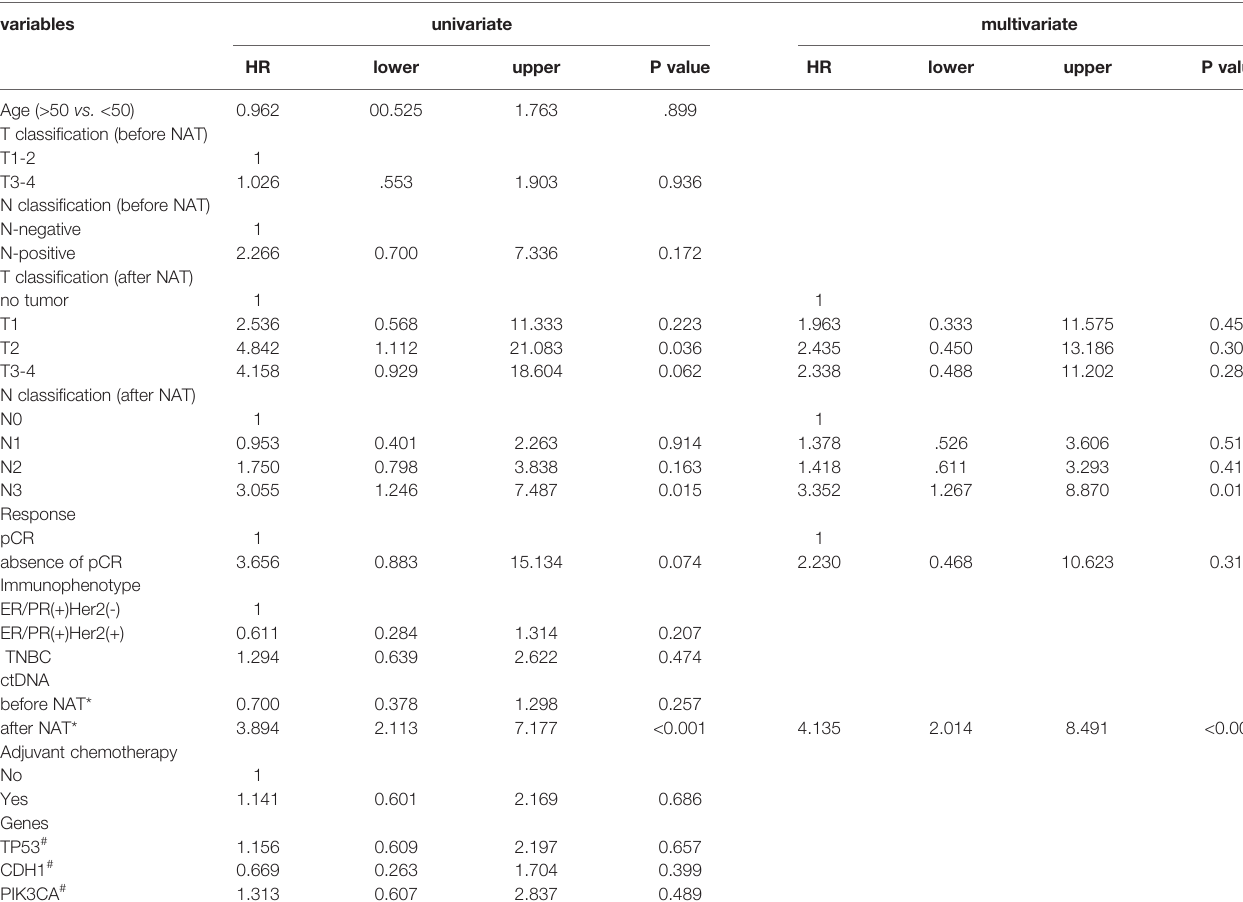
TABLE 2 | Univariate and multivariate analysis of recurrence-free survival of the entire cohort. variables univariate multivariate